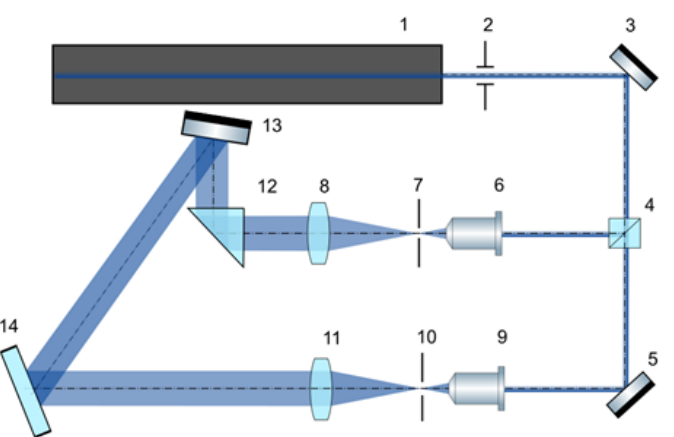
Figure 8. The scheme of analog recording of DOE. 1 — laser; 2 — shutter; 3, 5, 13 — mirrors; 4 — beam – 4—beam–splitting cube; 6, 9—micro lenses; 7, 10—aperture; 8, 11—lenses, 12—prism (mirror); splitting cube; 6, 9 — micro lenses; 7, 10 — aperture; 8, 11 — lenses, 12 — prism (mirror); 14 — photo- graphic substrate. 14—photographic